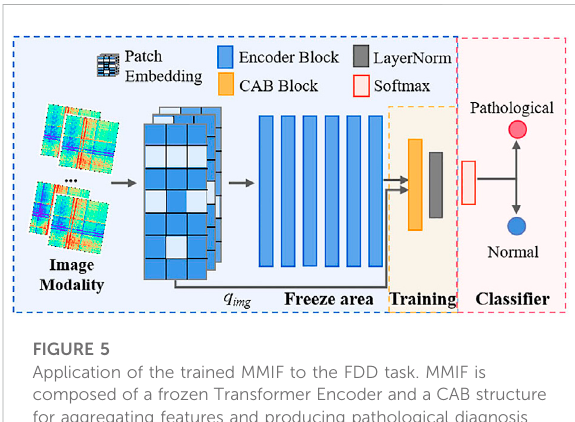
FIGURE 5 Application of the trained MMIF to the FDD task. MMIF is composed of a frozen Transformer Encoder and a CAB structure for aggregating features and producing pathological diagnosis